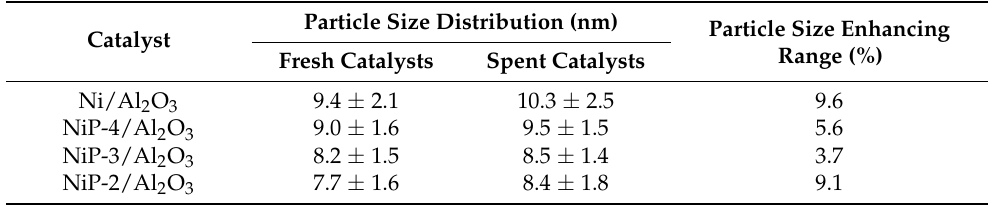
Table 3. Particle size distributions of fresh and spent Ni/Al 2 O 3 and NiP-x/Al 2 O 3 catalysts.